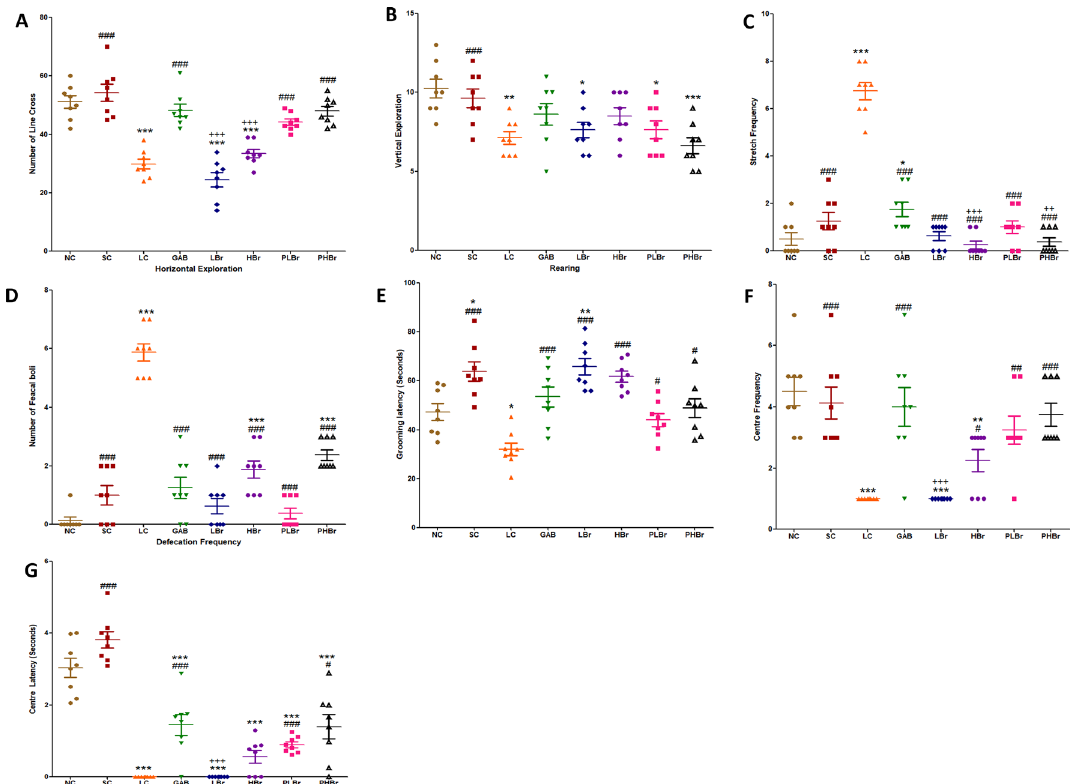
Figure 3. Bromelain reduced anxiety-like behaviour in sciatic nerve chronic constriction injury model of neuropathic pain in an open field maze. Each values represent mean ± SEM of each group (n = 8). ( A ) Horizontal line cross ( B ) rearing ( C ) Stretch frequency ( D ) Defecation frequency ( E ) Grooming duration ( F ) Centre frequency ( G ) Centre square duration. # p < 0.05, ## p < 0.01, ### p < 0.001 compared with ligated control; *p < 0.05, **p < 0.01, ***p < 0.001 compared with normal control; + p < 0.05, ++ p < 0.01, +++ p < 0.001 compared with reference control. NC unligated normal control, SC sham control, LC ligated control, GAB gabapentin reference control (30 mg/kg gabapentin), LBr low dose bromelain (30 mg/kg), HBr high dose bromelain (50 mg/kg), PLBr pre- treated low dose bromelain (30 mg/kg), PHBr pre-treated high dose bromelain (50